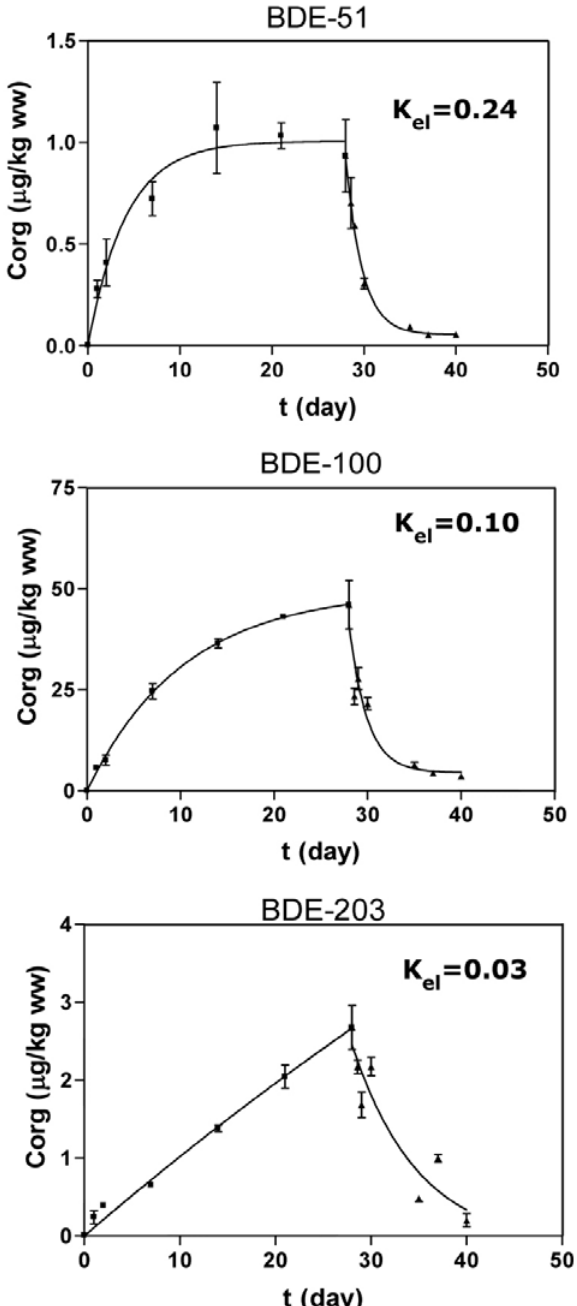
Figure 1. Time courses of the uptake and elimination of three PBDE congeners in T. tubifex in relation to k that the congeners reach a steady-state plateau in the test animal. Filled squares with error bars represent the measured concentra- tions on the sampling